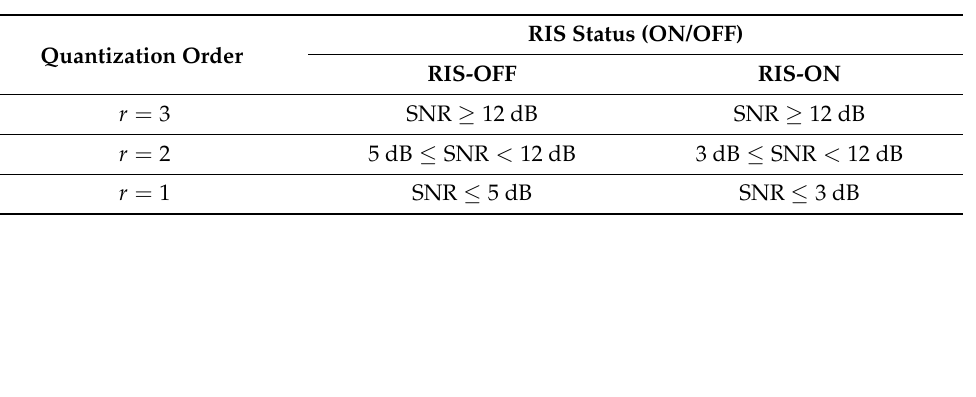
Table 2. The optimized SNRs for r = { 1,2,3 } , with/without the RIS, and the BMR ≤ 0.1